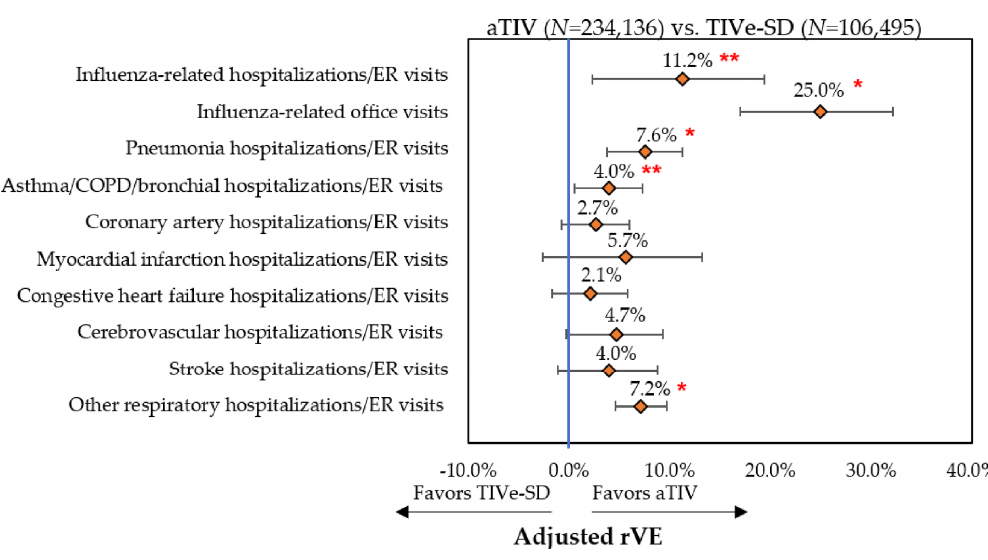
Figure 6. Adjusted rVE — post-IPTW and Poisson regression — aTIV vs. QIVe-SD. * p < 0.001; ** p < 0.05; rVE = relative vaccine effectiveness.